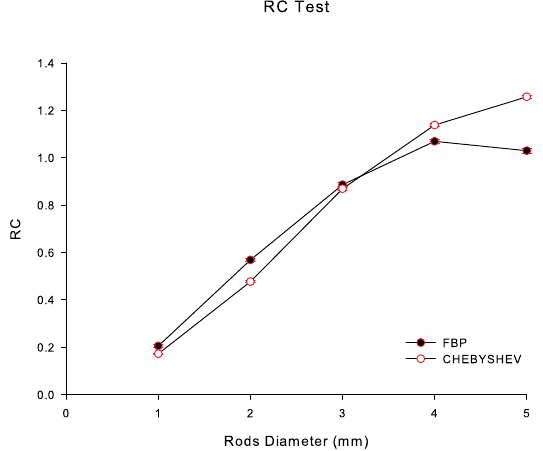
Figure 5. Recovery coefficient ( RC ) for all hot fillable rods in the hot region of the simulated IQ phantom as a function of rod diameter (in mm), for Chebyshev and FBP reconstructions in NL2.